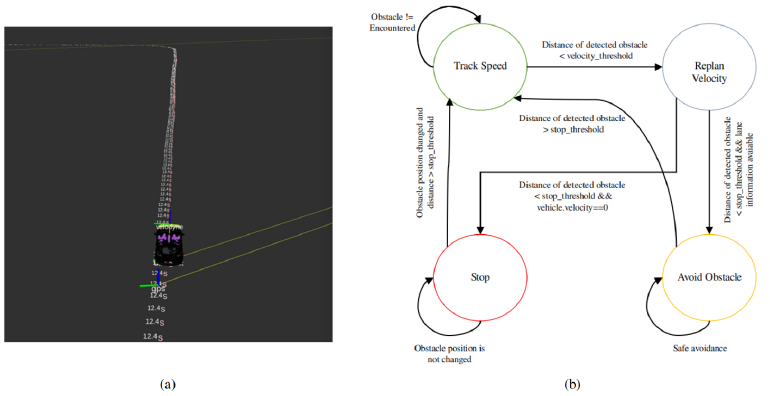
Figure 11. ( a ) The waypoints generated by the motion planning module that contains the GPS coordinates, velocities and angles. ( b ) The state-machine implementation for obstacle avoidance and stopping. The vehicle will approach to track the speed until the obstacle is not encountered. When the obstacle is detected, if the distance of detected obstacle is less than the velocity-threshold, the planner will replan the velocity to decrease the speed. After this there are two options for the vehicle, if the distance of the detected object is less than stop-threshold and lane information with change flag is available, then the vehicle will avoid the obstacle until the safe avoidance has not been done. In another case, if the detected obstacle distance is less than stop-threshold, and vehicle velocity is approaching to zero, the vehicle will stop until the obstacle position is not changed. Finally, suppose the obstacle position is changed, and the detected obstacle distance is greater than the stop-threshold. In that case, the vehicle will approach to track speed in stop case whereas in avoiding obstacle case if the distance of detected obstacle is greater than stop-threshold, it will approach to track speed (Best viewed in